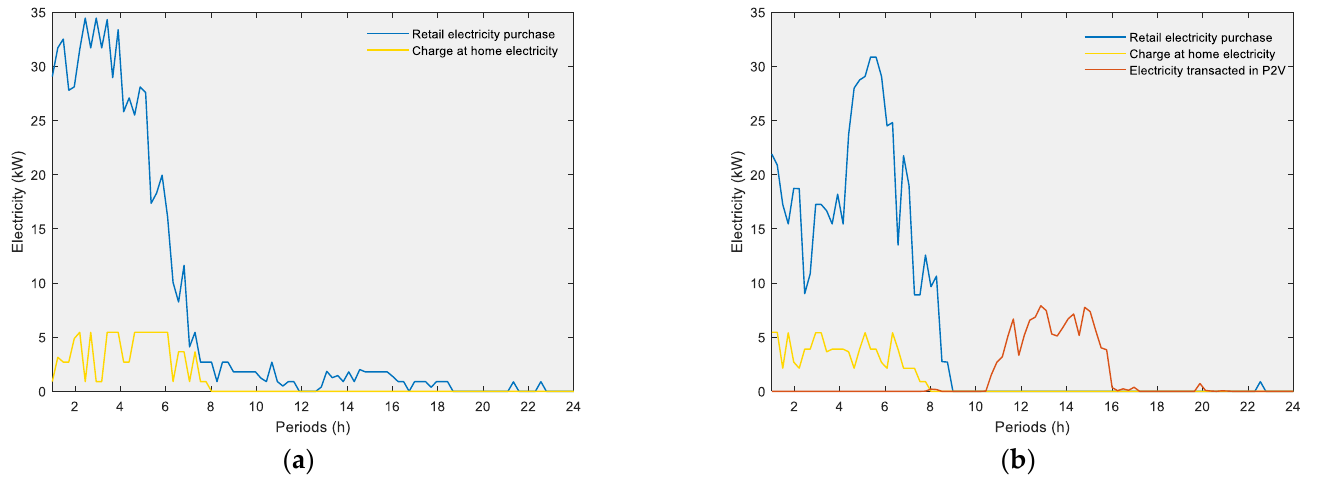
Figure 7. EV battery charge profile: ( a ) Scenario 1 and ( b ) Scenario 2.